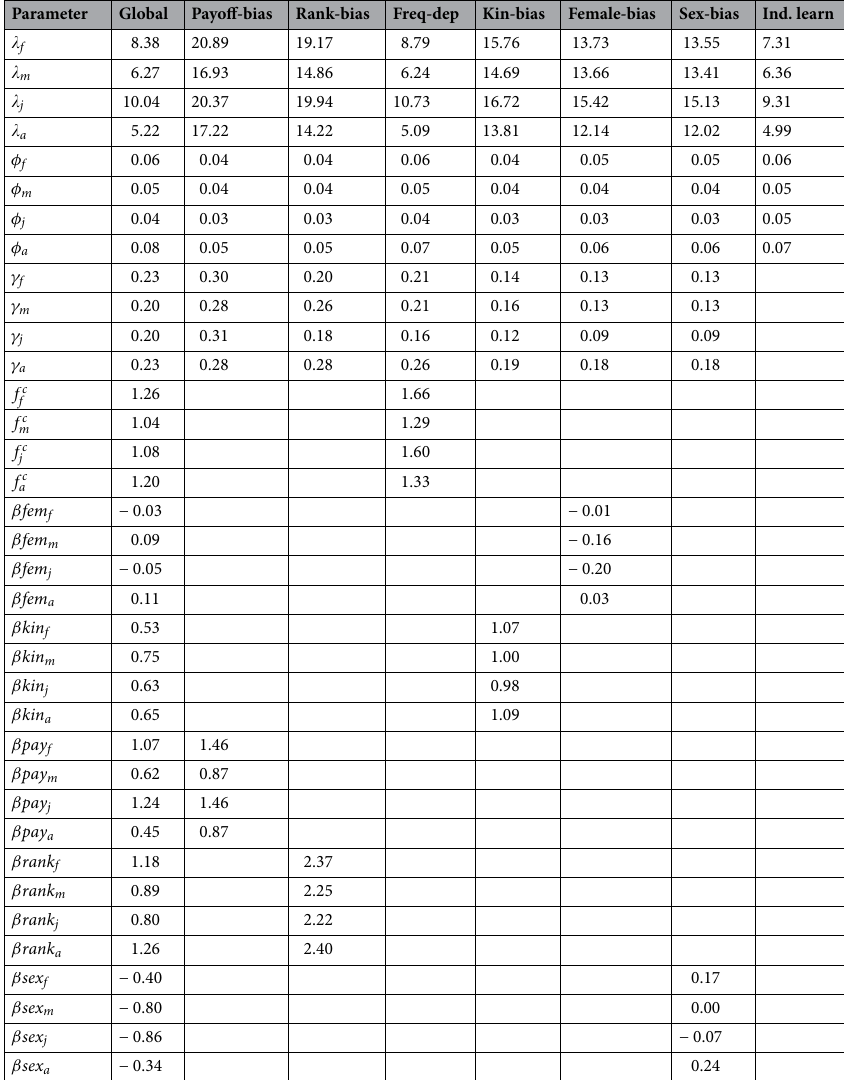
Table 2. Posterior mean estimates of learning parameters for all evaluated EWA models. Subscripts correspond to male (m), female (f), adult (a), and juvenile (j). Dot plots of these parameters, including 89% HPDI for the global model, including individual and group-level parameters, are in Figures